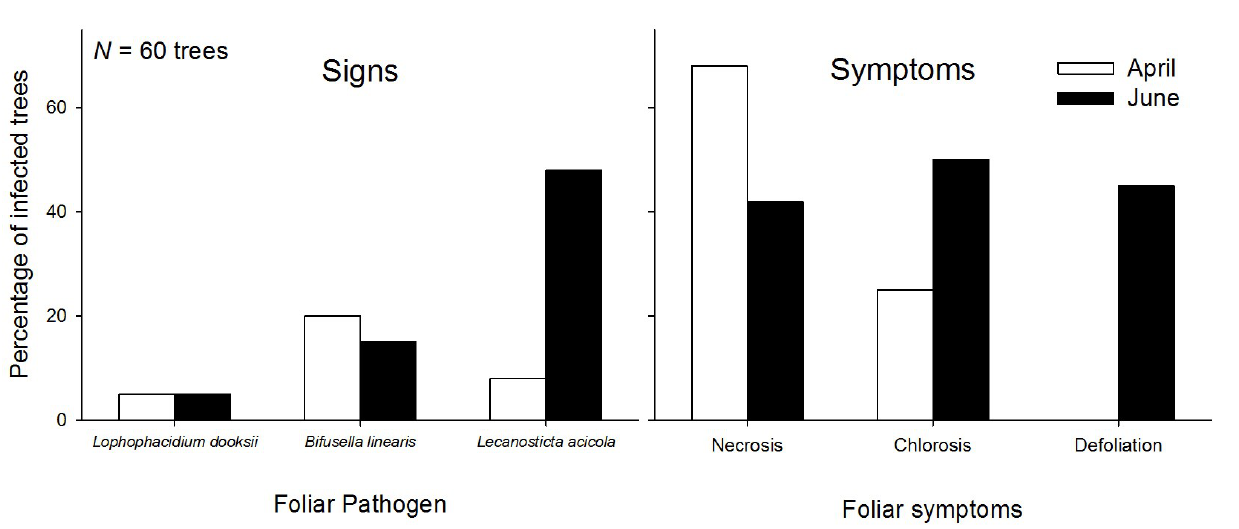
Figure 3. Frequency of foliar disease signs and symptoms on infected